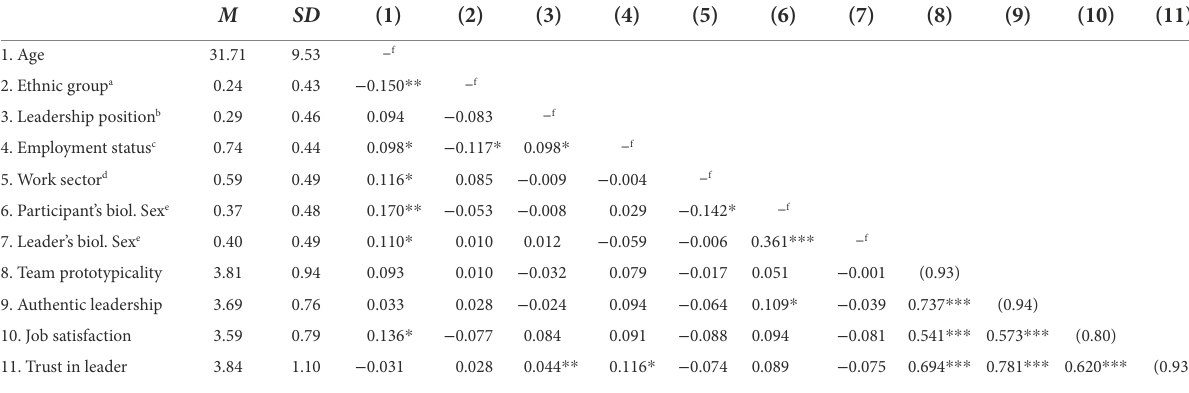
TABLE 4 Study 2: Means, standard deviations, intercorrelations, and